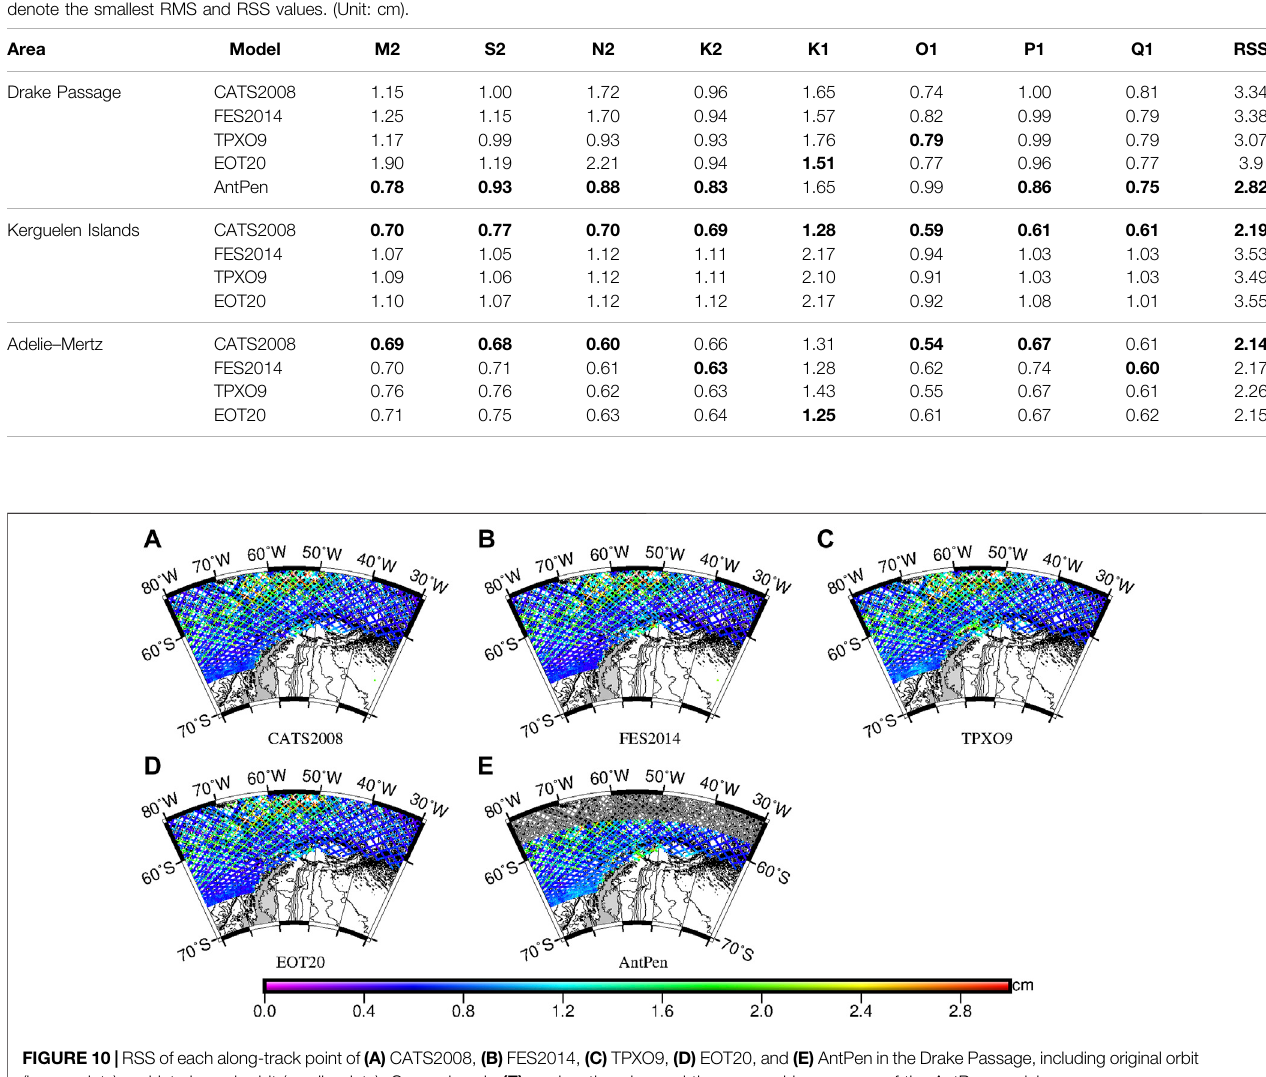
Frontiers in Earth Science |